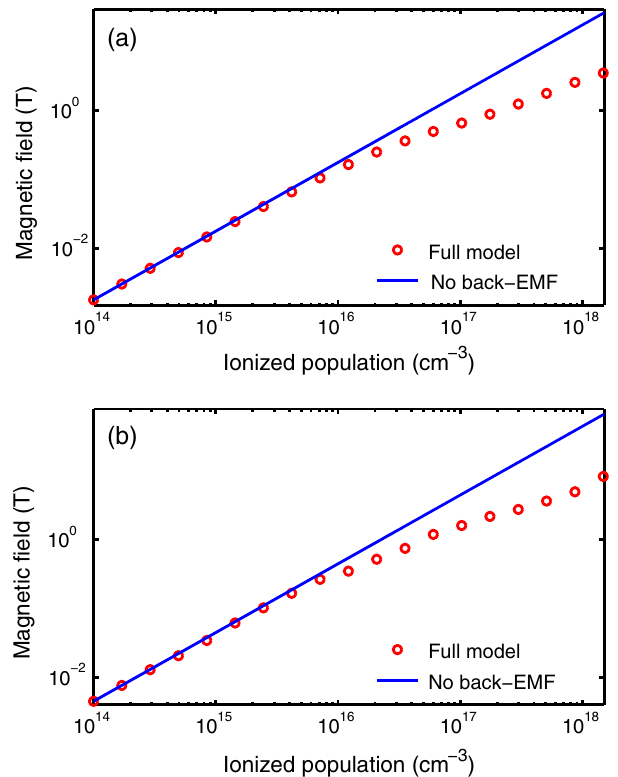
FIG. 4. The influence of back-EMF on magnetic field scaling. Simulation results for atomic hydrogen and helium, for a beam waist w 0 ¼ 100 μ m, fundamental wavelength λ ¼ 4 μ m, medium thickness L ¼ 150 μ m, equal ω = 2 ω pulse durations τ p ¼ 40 fs, and variable gas density. For each gas density, one simulation is performed without back-EMF included, and another including back-EMF is performed. (a) Magnetic fields calculated for atomic hydrogen [fundamental peak electric field E ω ¼ 2 . 9 V = Å ( I ω ¼ 1 . 1 × 10 14 W = cm 2 ), second harmonic peak electric field E ¼ 1 . 2 V = Å ( I ¼ 0 . 19 × 10 14 W = cm 2 )] reach a maximum 2 ω 2 ω amplitude of B ¼ 3 . 6 T and are significantly suppressed by back- EMF. (b) Because of a higher ionization potential, stronger electric fields [fundamental peak electric field E θ ; ω ¼ 7 . 4 V = Å ( I ω ¼ 7 . 3 × 10 14 W = cm 2 ) and second harmonic peak electric field E θ ; 2 ω ¼ 2 . 3 V = Å ( I 2 ω ¼ 0 . 70 × 10 14 W = cm 2 )] can be ap- plied to atomic helium while maintaining the same ionization dynamics. This method counteracts back-EMF and enables the generation of magnetic fields up to B ¼ 8 . 4